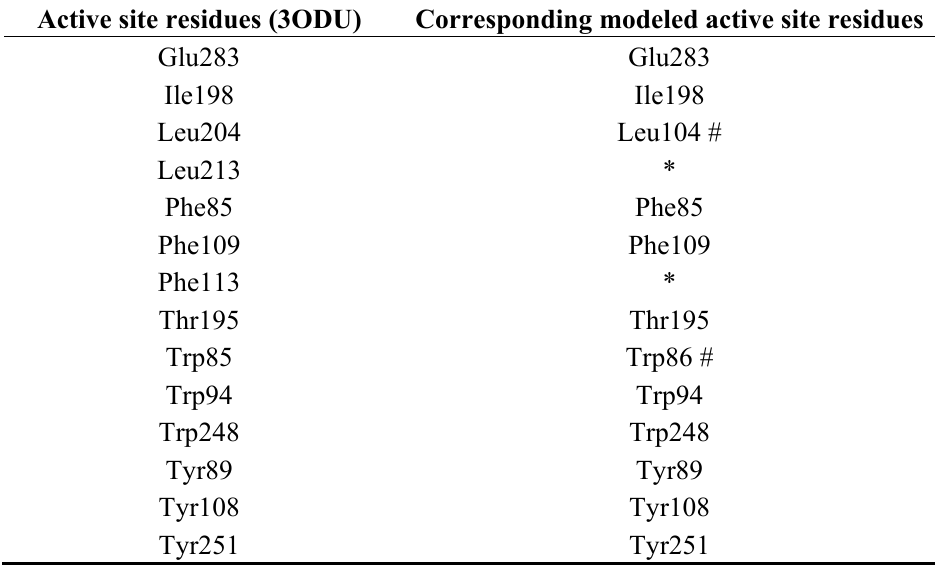
Table 2. Comparison of the active site residues between the modeling template (3ODU) and modeled